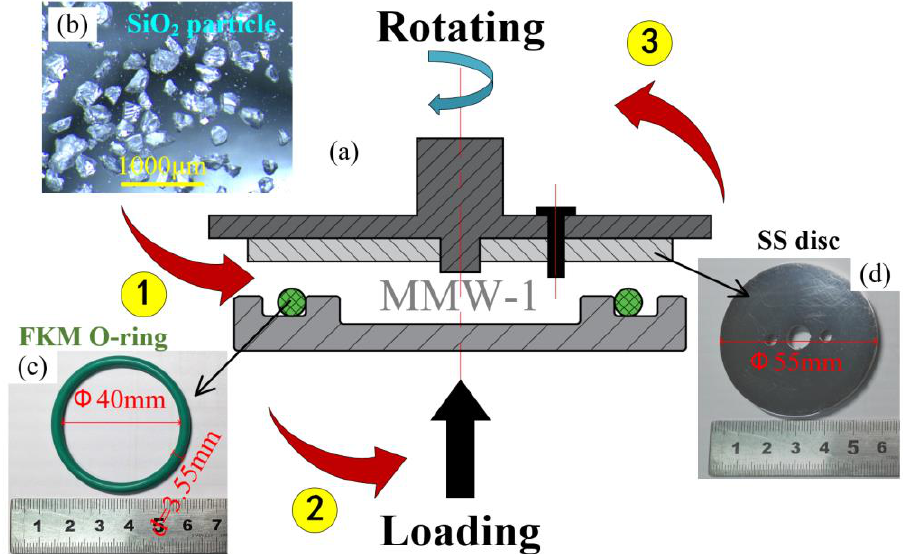
Figure 1. Schematic diagrams of ( a ) MMW-1 wear test rig (not to scale), and the inserts are ( b ) the optical micrograph of abrasive particles and ( c ) the pictures of the FKM seal and ( d ) metal disc, respectively. Table 1. Dimensions of FKM rubber seals and stainless steel disc.